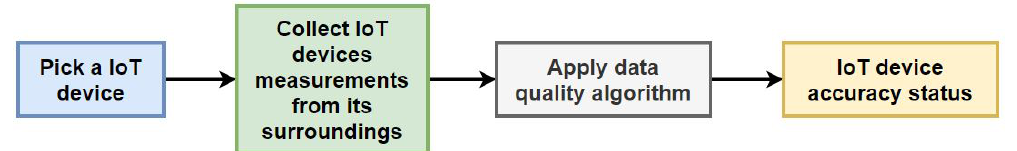
Figure 2. Flowchart to show how an IoT device is determined to be an accurate or inaccurate device.